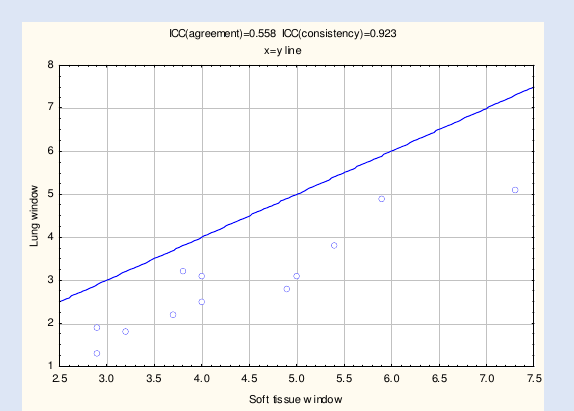
Graph 6. Comparison between measurements in soft tissue and lung windows in the right main bronchus.